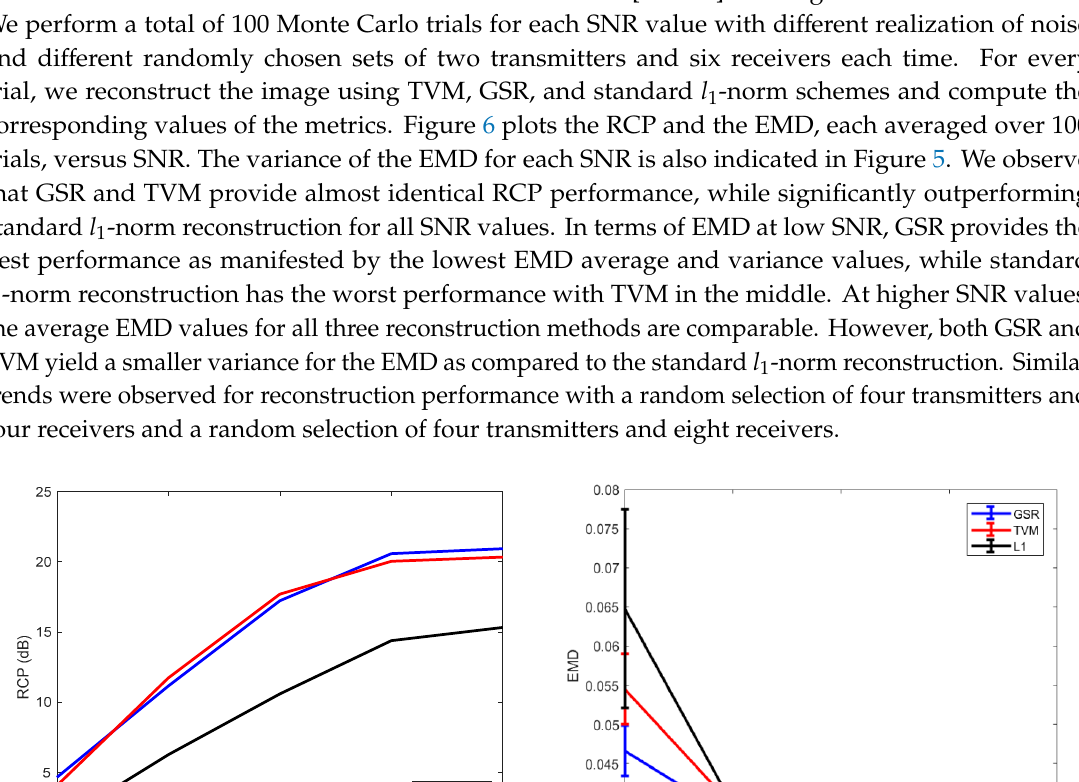
six receivers. ( a ) GSR; ( b ) TVM; ( c ) standard 𝑙 (cid:2869) ‐ norm minimization.